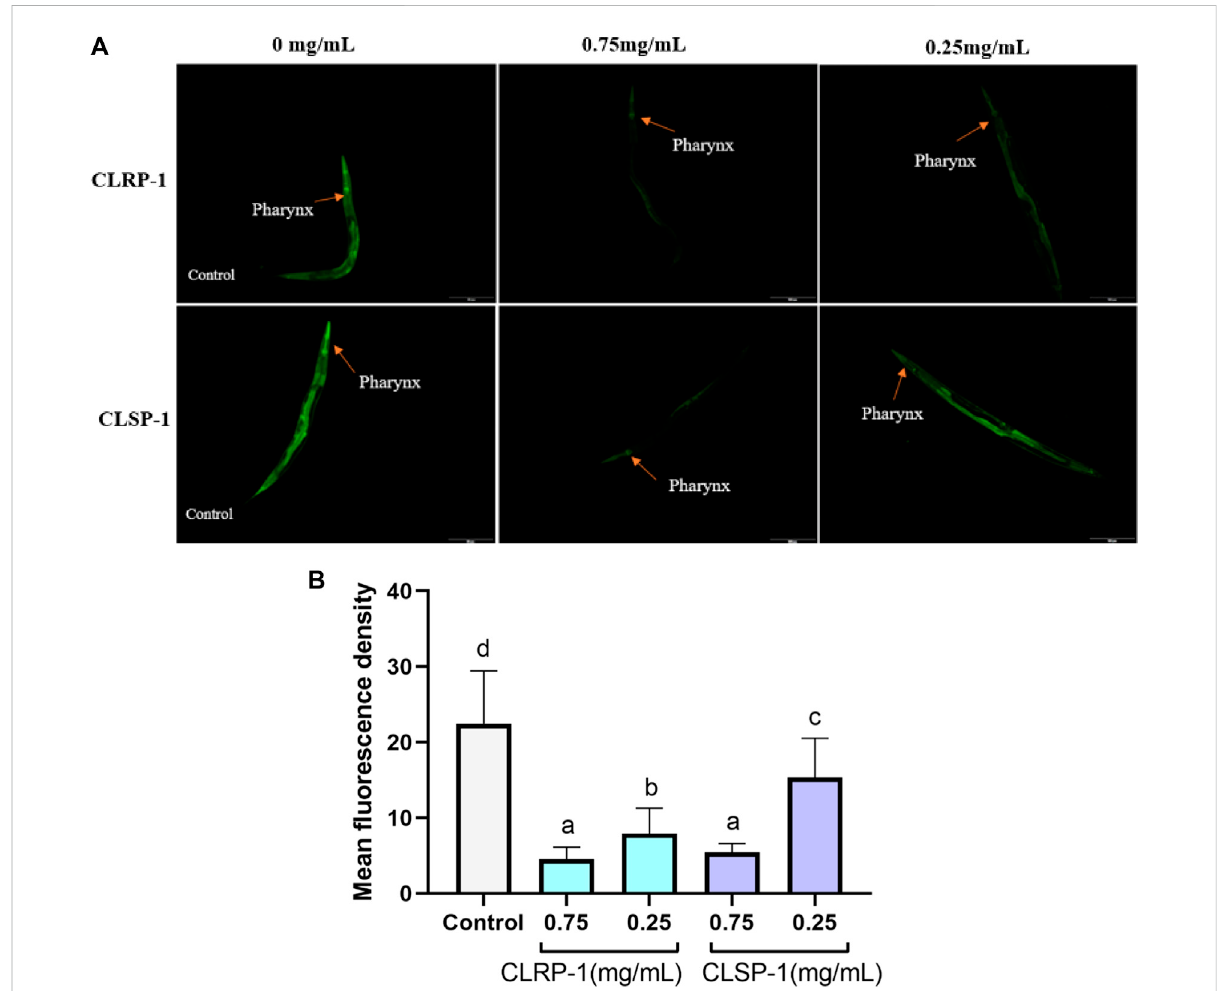
FIGURE 6 EffectofCLRP-1andCLSP-1ontheexpressionofHSP-16.2:GFPunderthermalstress. (A) TheHSP-16.2::GFPexpression. (B) CLRP-1andCLSP- 1 could reduce the on the HSP-16.2::GFP expression under thermal stress. Bars with different lowercase letters (a – c) are signi fi cantly different ( p <